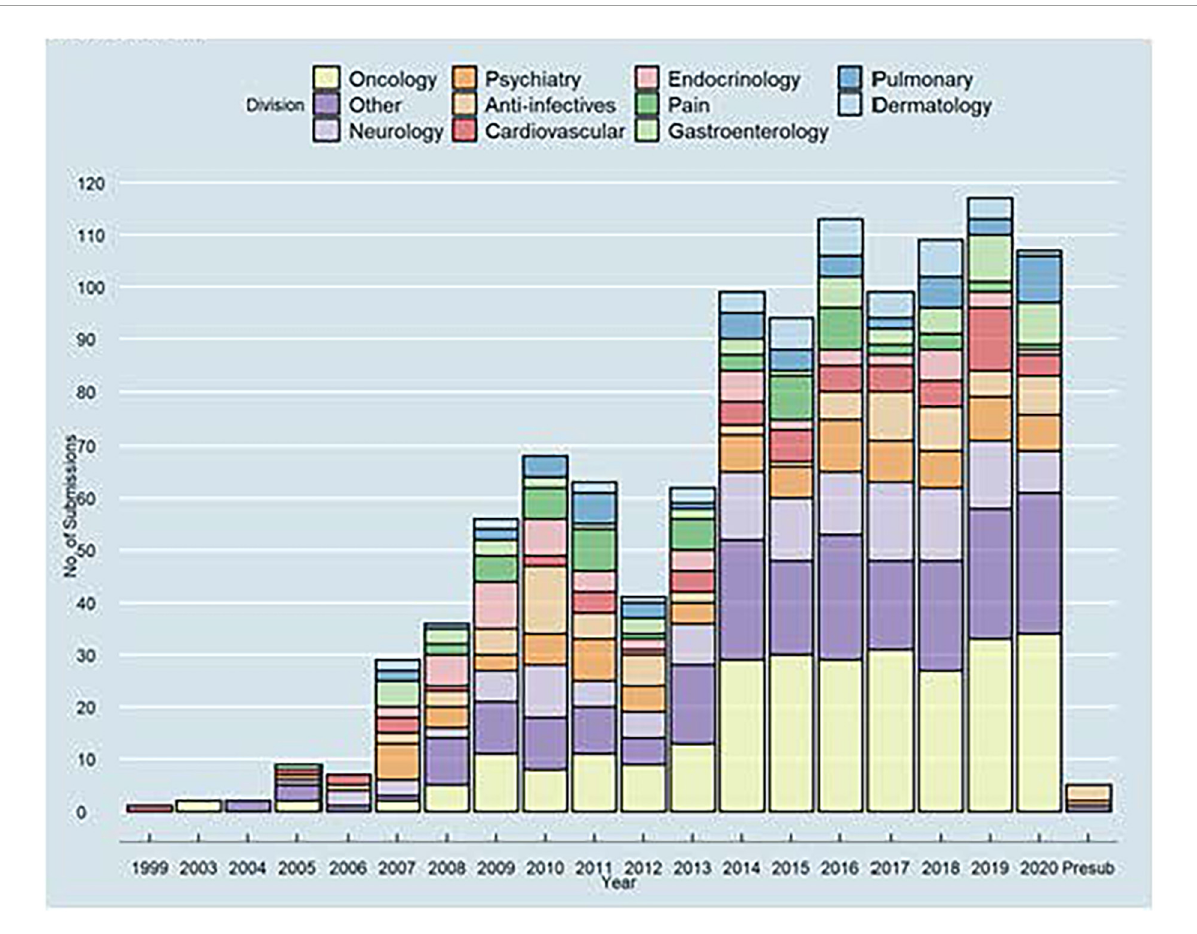
FIGURE6 Division of applied regulatory science (DARS) manually extracted data from a variety of secondary pharmacology reports submitted by sponsors. The extracted data was then curated into a database (43) to allow for easier access and analysis by the